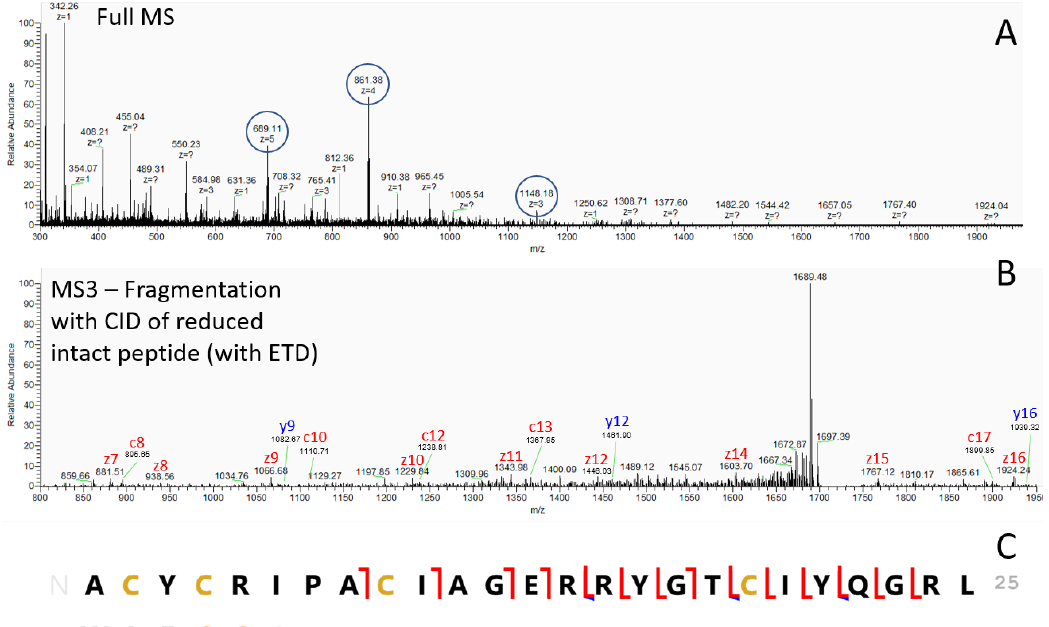
Figure 2. Mass spectra and annotated sequence of neutrophil defensin 1. ( A ) Full mass spectrometry (MS) spectrum of intact neutrophil defensin 1, in three different charge states (3, 4 and 5, indicated by blue circle). The five charged ion with m / z 688.91 (mass 3439.55 Da as obtained with MSI in Figure 1 is selected for reduction of the three disulfide bridges with electron-transfer dissociation (ETD) and the reduced, intact peptide is immediately selected for fragmentation with collision-induced dissociation (CID); ( B ) The resulting fragmentation spectrum with c, y and z type ions. A sequence tag is depicted on the fragmentation spectrum; ( C ) Annotated sequence of neutrophil defensin 1 with all matched deconvoluted fragments (see also Table 1, mass accuracy was set at 300 ppm) (y ions are indicated in blue, while c and z ions are indicated in red), obtained with both CID as ETD as fragmentation method. See also the Appendix A for more details.